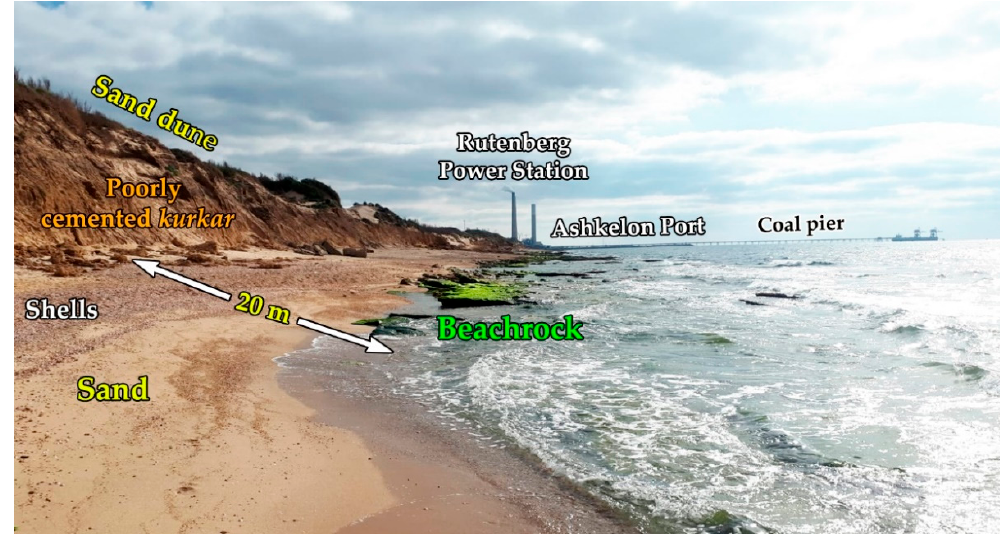
Figure 4. The eroded beach south of Tel Ashkelon. View to southwest, about 3 km from Ashkelon Port (photographed by Amir Arad, 10 March 2019).